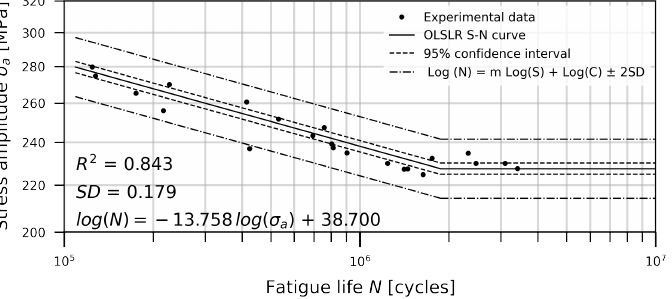
Figure 6. S-N curve obtained from the rotating bending experiments ( R = − 1) for specimens extracted from the rolling